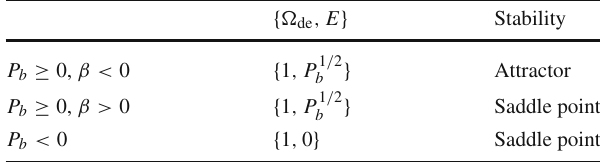
Table 4 The stability of the GP